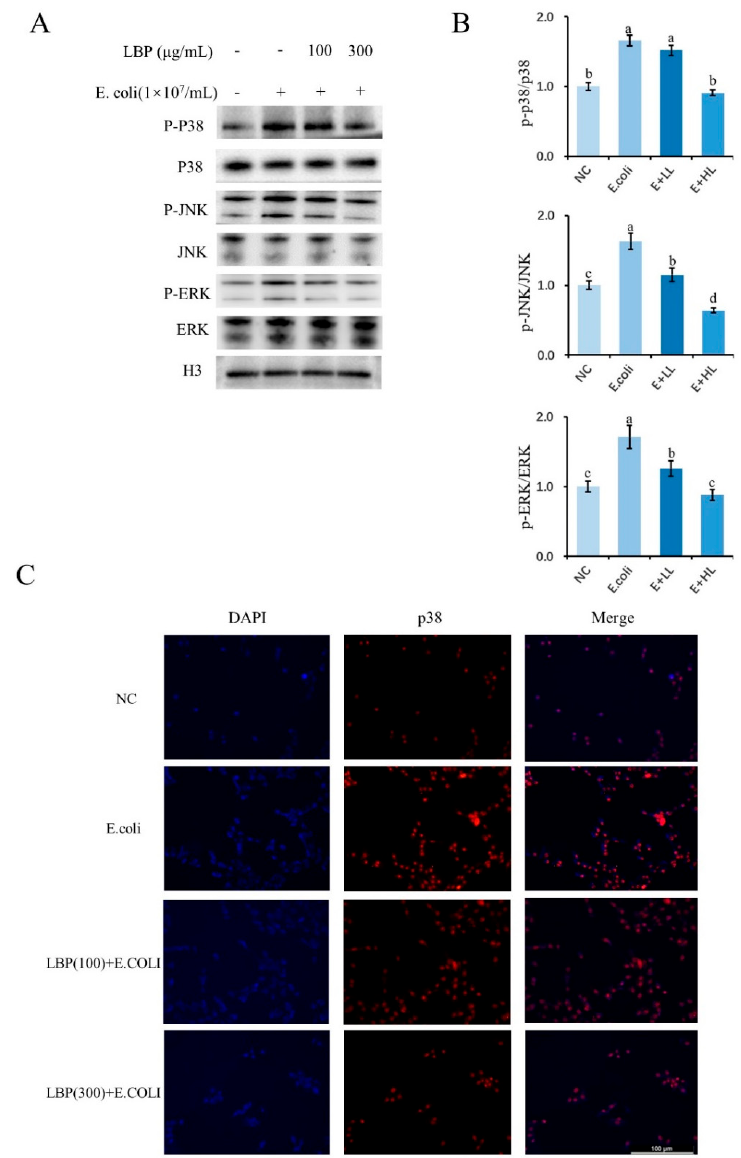
Figure 5. Expression of proteins related to MAPK signaling. Different doses of LBP at 100 µ g/mL or 300 µ g/mLwere added to pbMEC, followed by a challenge with 1 × 10 7 /mL E. coli for an additional 6 h. ( A ) Western blots of the components of MAPK signaling. ( B ) The ratio of p-p38, p-JNK and p-ERK to total p38, JNK and ERK abundance. ( C ) Fluorescence detection for SOCS3 (Cy3 labeled, red) was performed, and the nucleus was stained with dye DAPI (blue). Results are expressed as means ± SEM. Results are presented as means ± SEM. Superscripts represent that the difference between groups was significant according to statistical analysis ( p < 0.05).